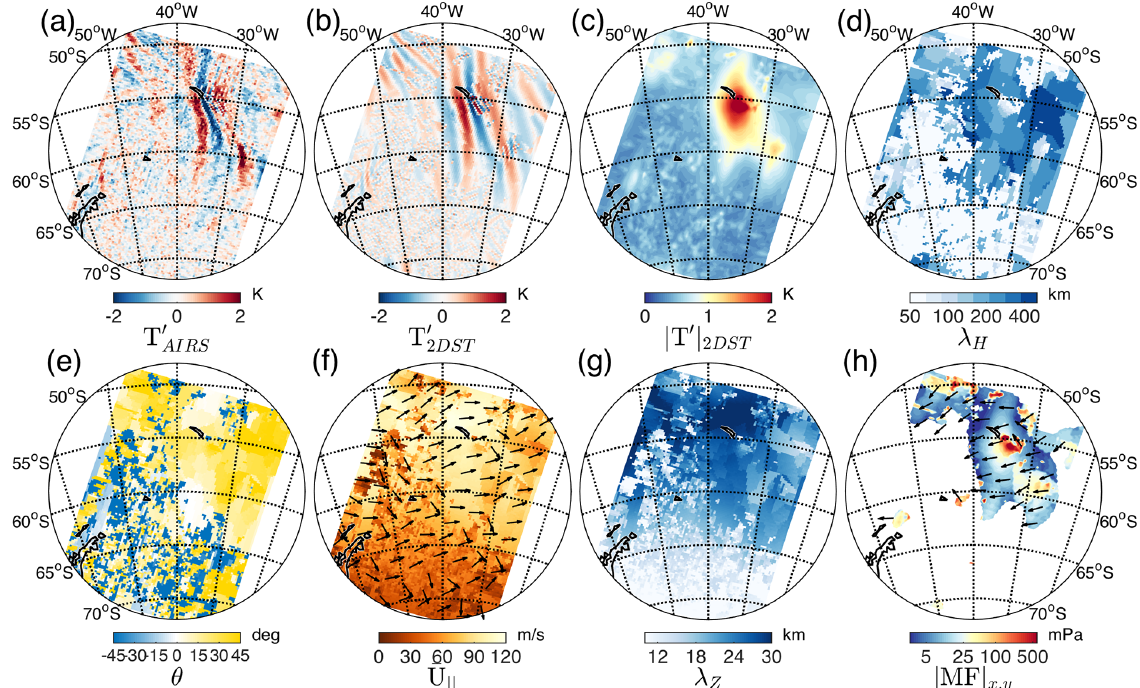
Figure 5. Orthographic projections of a granule of AIRS brightness temperature measurements T (cid:48) (a) over South Georgia at around AIRS 03:00UTC on 6 September 2003 and selected outputs (b–e) of our 2DST analysis using the Elliptic–Bessel window. This granule was also analysed by Alexander et al. (2009) (their Fig. 3) using a one-dimensional S-transform method. The 2DST outputs shown here are (b) , underlying wave amplitudes | T (cid:48) | 2 − DST (c) , horizontal wavelengths λ H (d) reconstructed brightness temperature perturbations T (cid:48) 2 − DST and wave propagation directions θ (e) in degrees anticlockwise from the east. Also shown are mean wind speed parallel to the horizontal wavenumber vectors U || (f) from ECMWF operational analyses at z ≈ 40km, vertical wavelengths λ Z (g) and the magnitude of the horizontal component of vertical momentum flux | MF | x,y (h) . Black arrows in (f) and (h) show the horizontal direction of U || and | MF | x,y respectively. For details, see